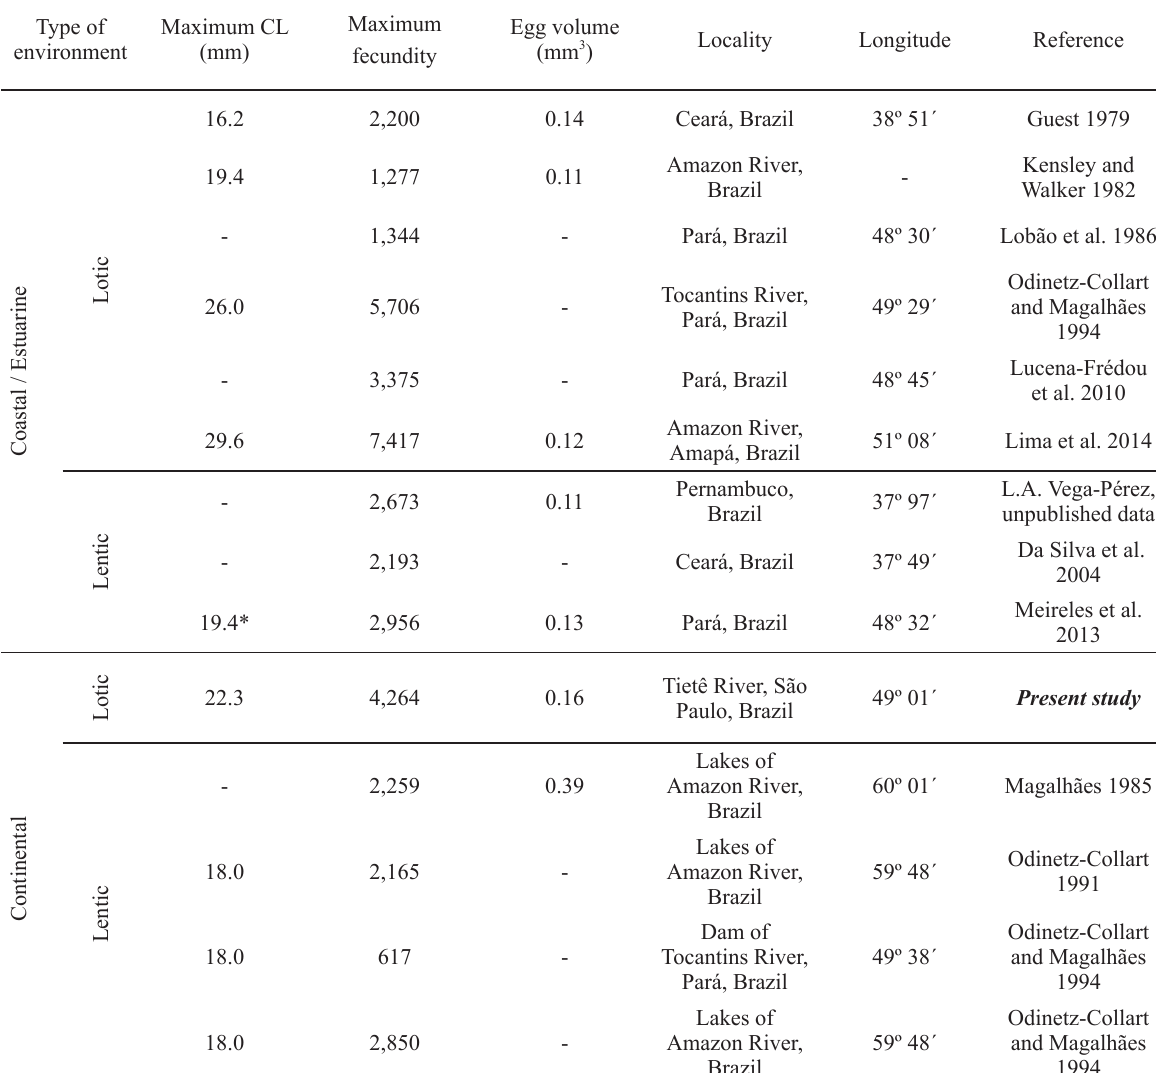
* = mean values. Egg volume estimated by egg size data, when